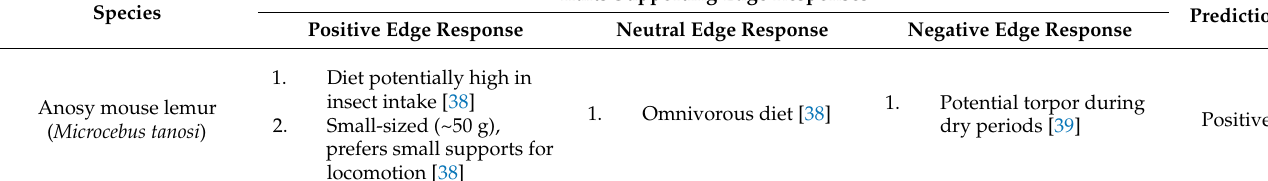
Table 1. Traits considered to predict the edge responses of lemur species at the Ampasy valley, north of the Tsitongambarika lowland rainforest, southeast Madagascar. When information on the species was not available, we considered information on other species from the same genus. The prediction is based on the category with more frequent traits. If no category is dominant, we predicted a neutral edge response since we predict the animals to balance these traits so that they do not prefer any particular